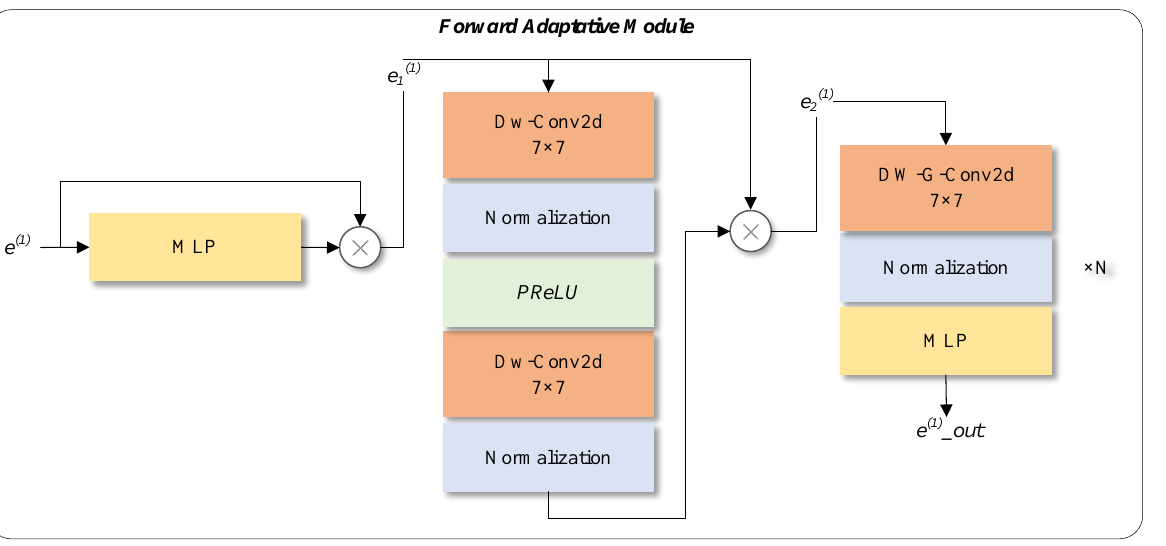
Figure 3. The Forward Adaptive Module structure is designed to enhance the adaptability of the model to features.